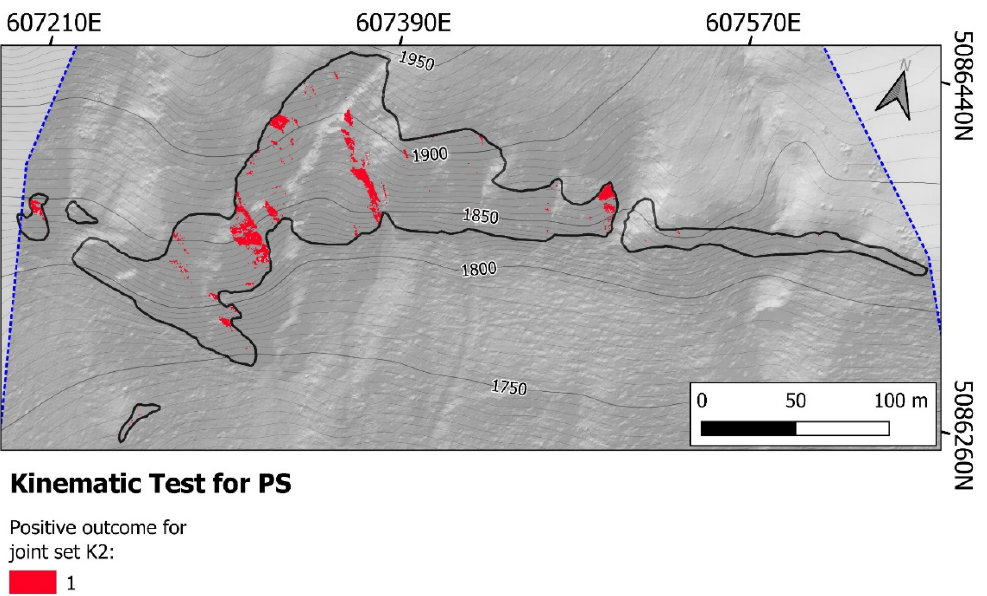
Figure A2. Image of the partial output file showing the kinematic test for PS performed considering only joint set K2.